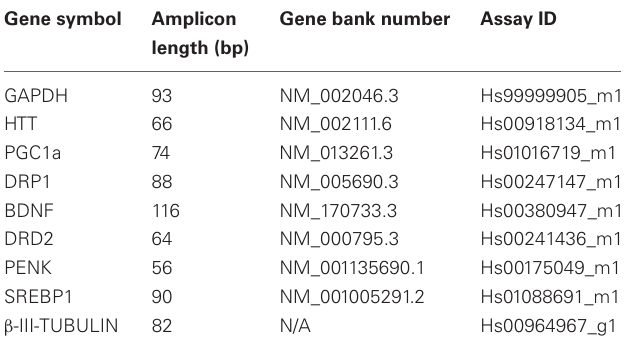
Table 2 | TaqMan gene expression assay details used for